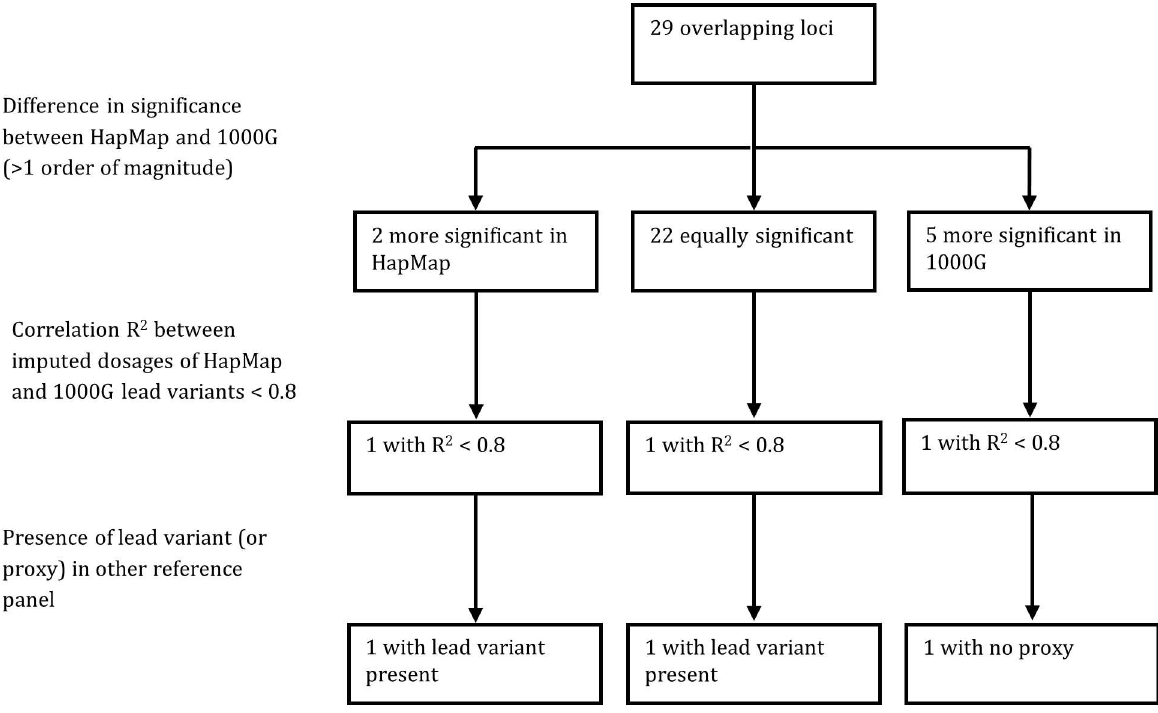
Fig 5. Summary of the differences between HapMap and 1000G imputation for the 29 overlapping